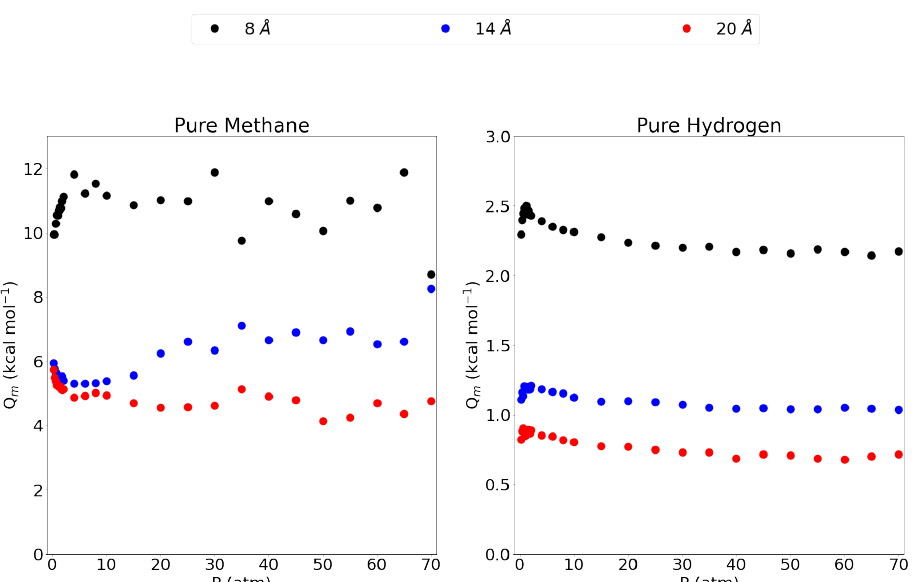
Figure 4. The isosteric heat of adsorption for methane and molecular hydrogen within the inves- tigated pores and at the entire pressure range considered and at 300 K. Please notice the different scales on the